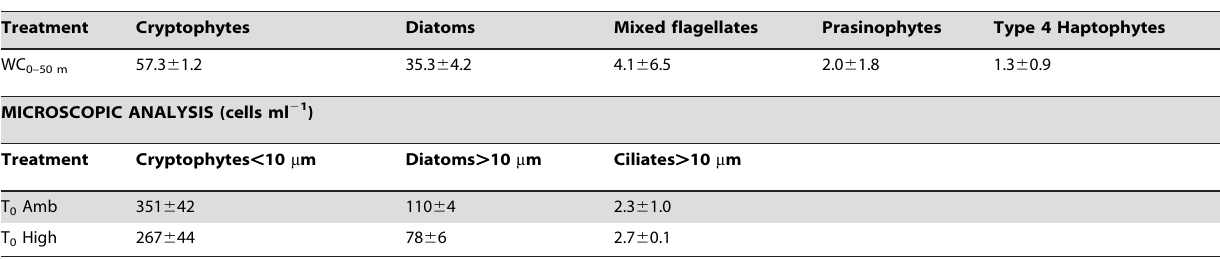
HPLC PIGMENT CHEMTAX ANALYSIS (% contribution to Chlorophyll a )